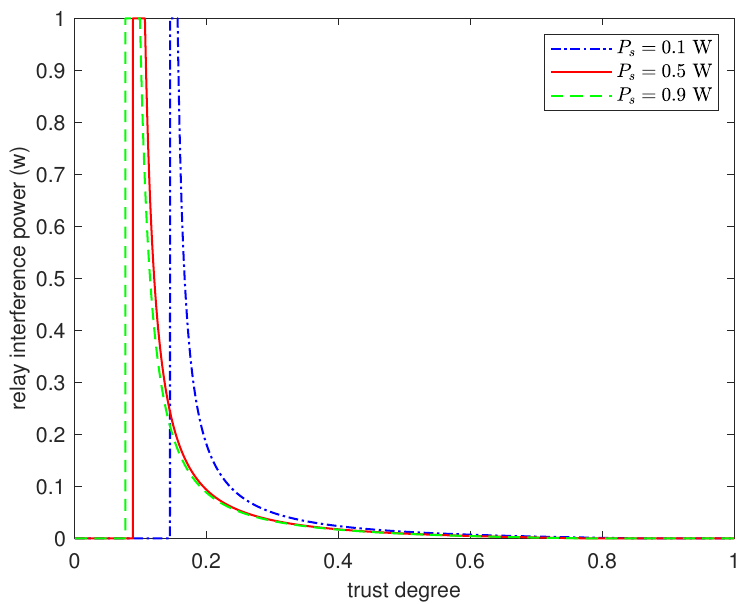
Figure 6. Relay interference power versus trust